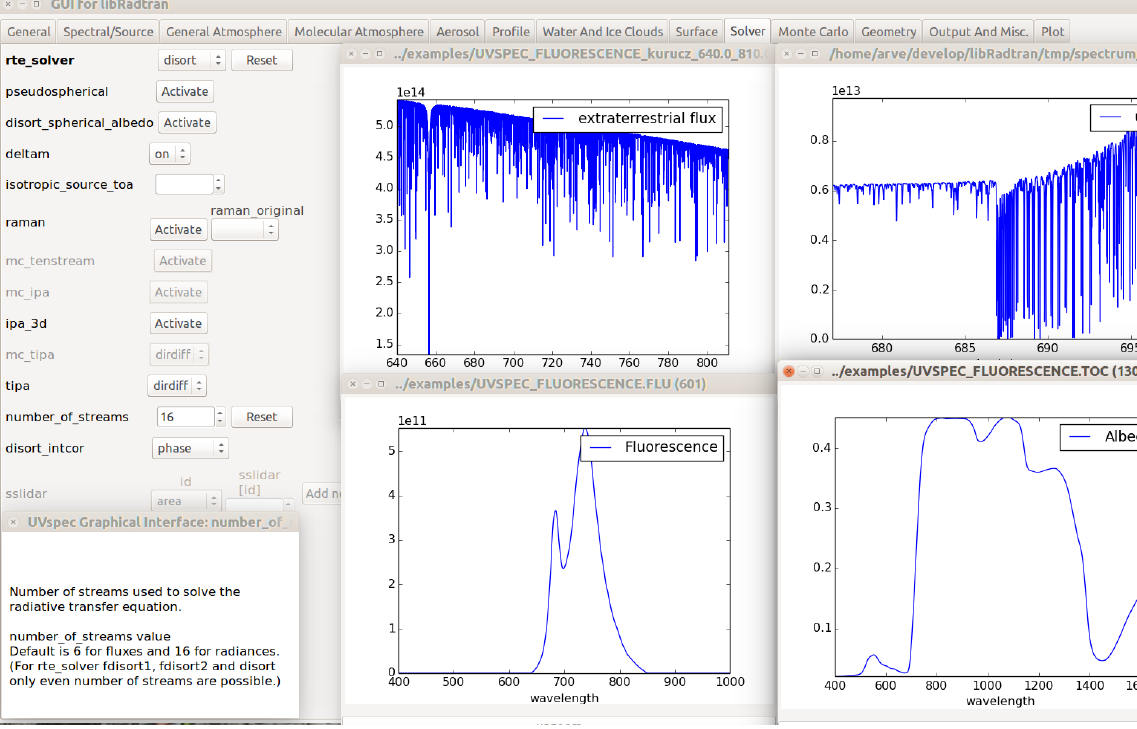
Figure 6. Screenshot of the graphical user interface for a spectral high-resolution simulation of the O 2 -B band including a fluorescence source. Plots of input and output data are included together with the help information for one option. See text for further